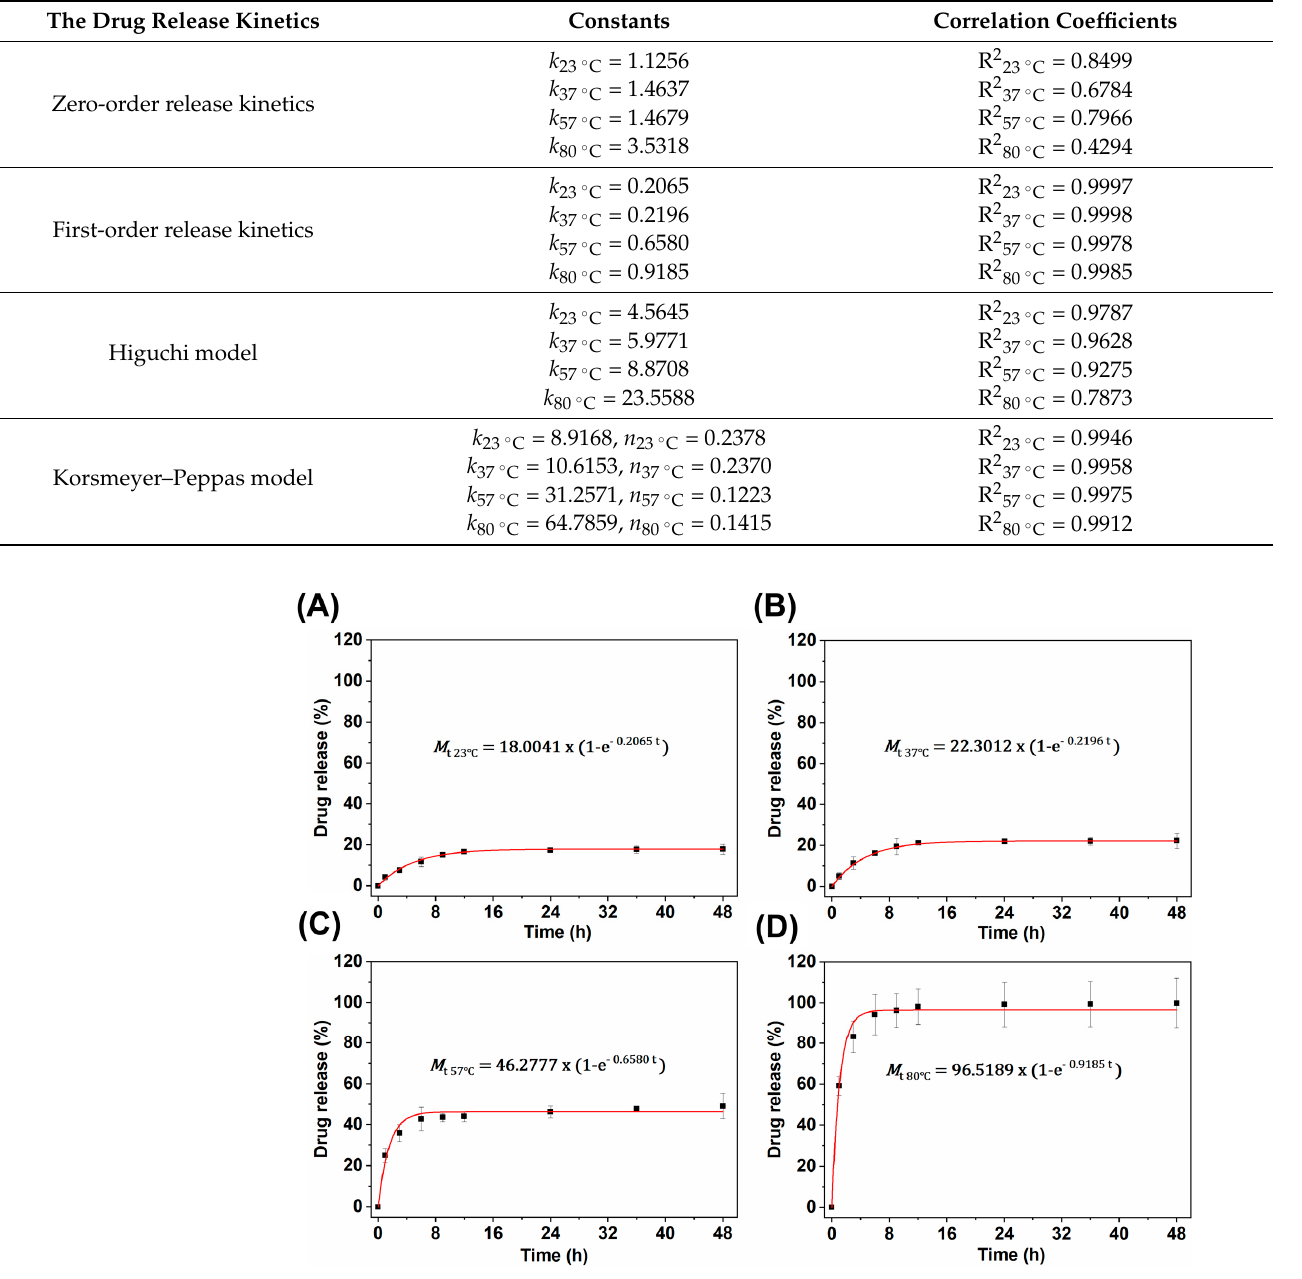
Figure 5. First-order model fitting curves and their equations for ( A ) 23 °C, ( B ) 37 °C, ( C ) 57 °C and ( D ) 80 °C.